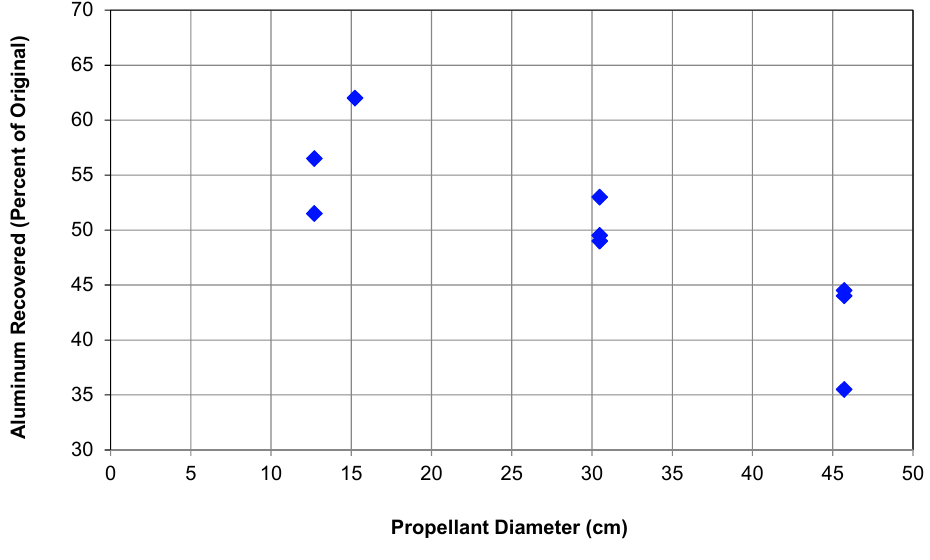
Figure 7. Fraction of original aluminum content of propellant charge which remains as residue after the burn.